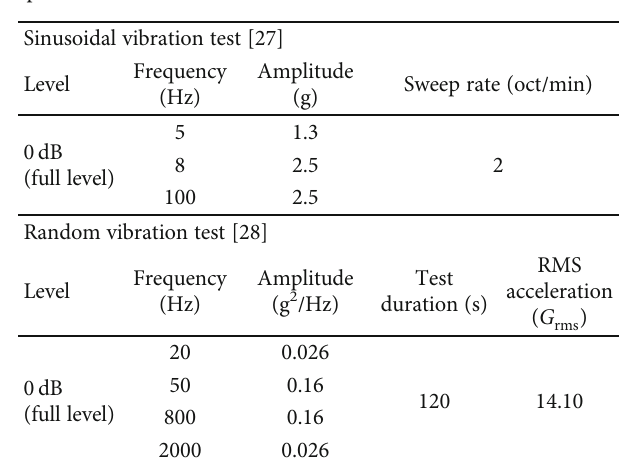
Table 3: Summary of quali fi cation level launch vibration